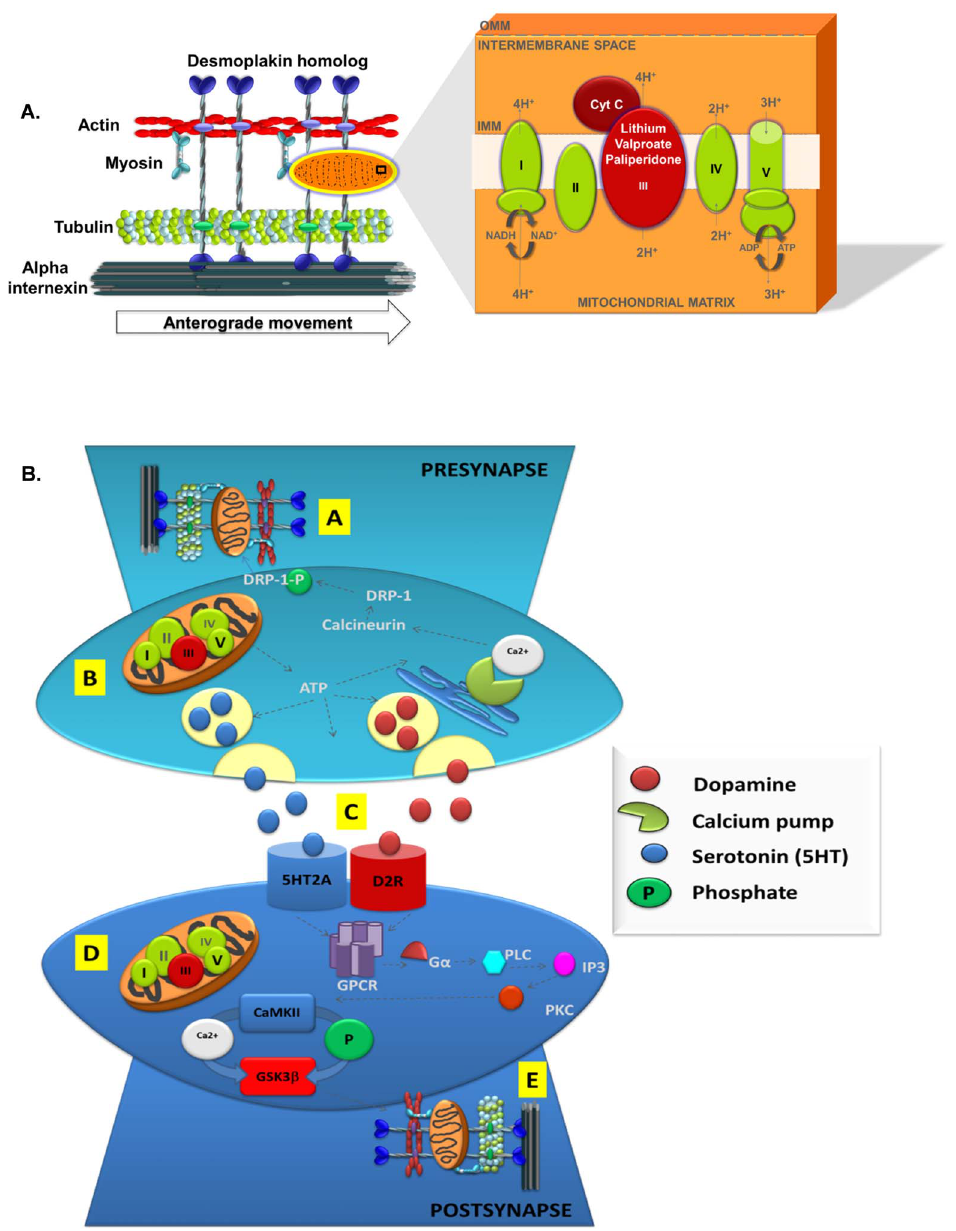
Figure 4. Simplified scheme to illustrate the effects of lithium, valproate and paliperidone treatment on mitochondrial and cytoskeletal protein phosphorylation with effects on mitochondrial transport towards the synapse. A. Cytoskeletal proteins (desmoplakin homolog, myosin, actin, tubulin and alpha internexin) are phosphorylated and involved in the mechanism of anterograde mitochondrial transport. Actin fiber formation is promoted by phosphorylation of actin isoforms. Actin binding domains indicated as purple ovals contribute to network formation through binding of desmoplakin homolog to actin. Phosphorylation of tubulin isoforms promotes microtubule formation and binding to desmoplakin homolog is facilitated through tubulin binding domains (green ovals). Tubulin in turn binds alpha internexin. Anterograde mitochondrial movement is possible through Myosin interaction with actin. Inside the mitochondria (insert), UQCRC1 from complex III (red) was phosphorylated after treatment with all three drugs with effects on mitochondrial function. B. Schematic representation of the effects of anterograde mitochondrial movement on synaptic plasticity and neurotransmission. Each step where the drugs have effects is indicated by a yellow square and a letter inside. These events may or may not happen simultaneously. A. Anterograde mitochondrial movement to the pre-synapse is promoted by all three drugs. B. Mitochondrial function near SNARE complexes provides necessary ATP for neurotransmitter release as well as regulation of Ca 2 + levels. Myosin heavy chain also plays a role on synaptic vesicle opening. Ca 2 + affects calcineurin which in turns affects DRP-1. Phosphorylation of DRP-1 influences mitochondria. C. Serotonin and dopamine release is regulated by 5HT2A and D2 receptors. The ratio of serotonin (5HT) and dopamine (DA) available regulates mitochondrial movement to the post-synapse as serotonin promotes anterograde movement while dopamine inhibits it. D. Mitochondrial function at post-synaptic terminals contributes to Ca 2 + homeostasis influencing CAMKII and GSK3 b E. Mitochondrial transport to the post-synapse results in increased levels of ATP necessary for proper functioning of post-synaptic machinery. The number of mitochondria is directly and reciprocally related to the number of active synapses (Li et al., 2004).